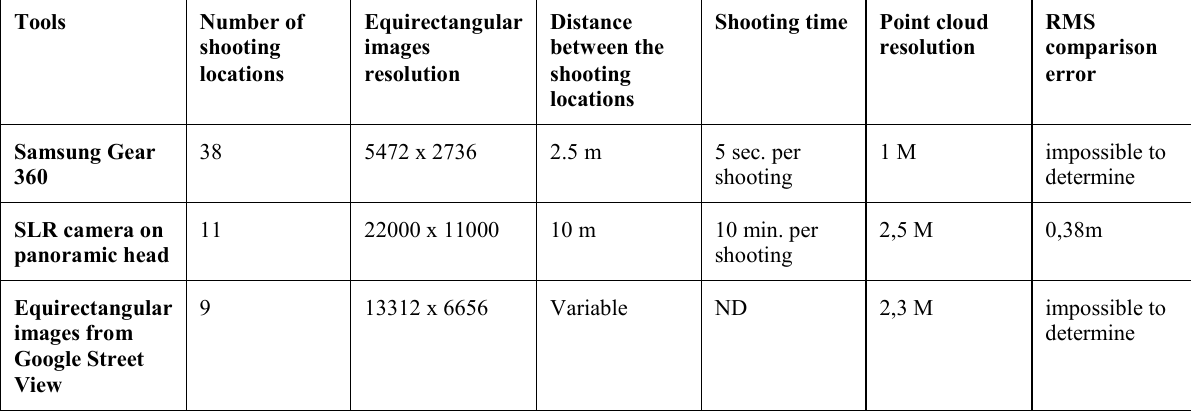
Tab. 1: Comparison of data in relation to the acquisition and processing